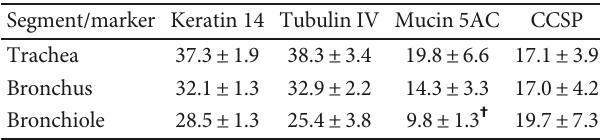
Table 1: Composition of epithelial cell types in di ff erent segments of large conducting airway of an adult pig lung